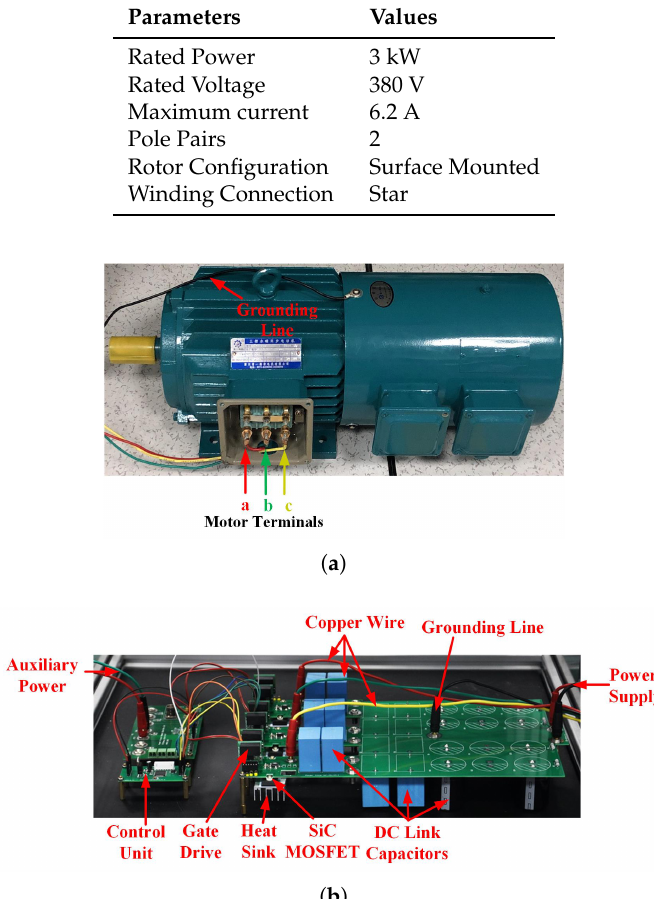
Figure 11. Experiment bench of the motor drive: ( a ) Motor, ( b ) Main circuit board of the motor